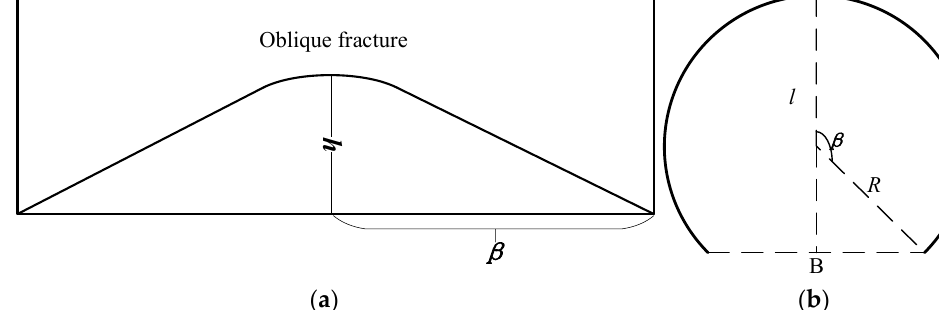
Figure 26. Schematic for the calculation of dip angle of oblique fracture. ( a ) Side expanded view of oblique fracture. ( b ) Projection of oblique fracture on the horizontal plane.